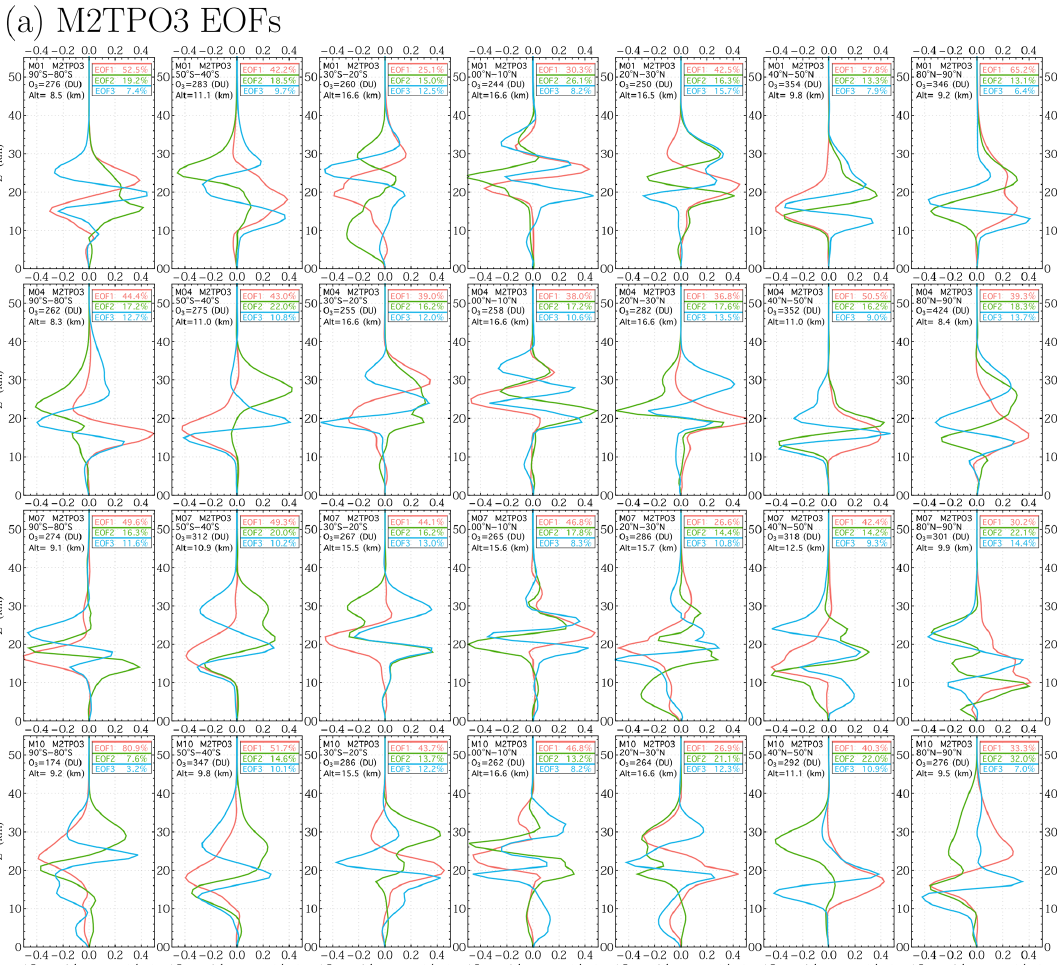
Figure 9. The empirical orthogonal functions (EOFs) of covariance matrices shown in Fig. 8. Only the first three ordered EOFs are plotted, with percentages of the class variance explained by the EOFs displayed with the corresponding line